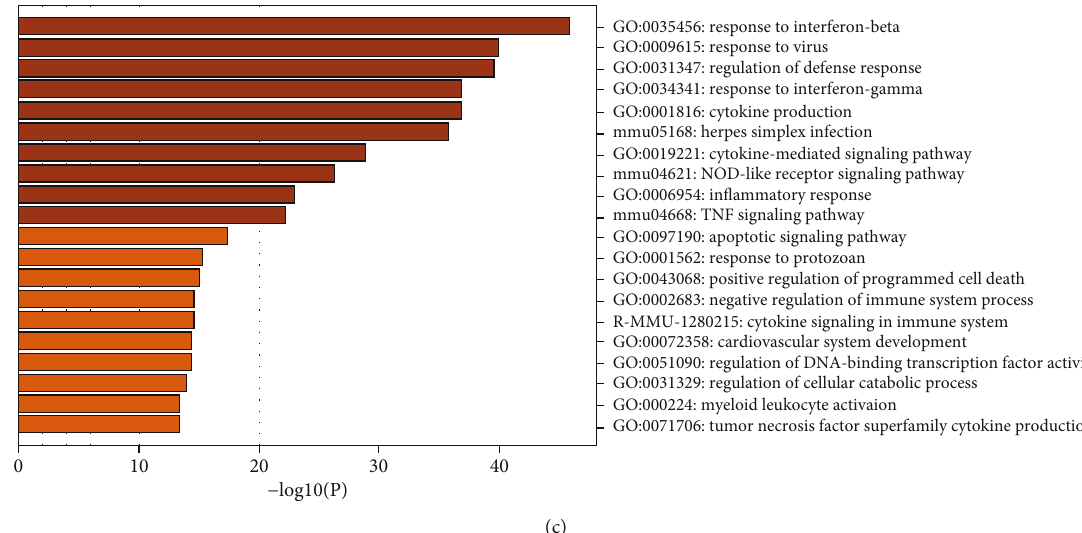
Figure 4: Microarray analysis highlighting di ff erentially expressed genes in preconditioned MSCs. (a) Heatmap representing gene expression in MSCs with and without preconditioning. (b) Top 30 of up- and downregulated genes in MSCs after preconditioning. (c) GO enrichment analysis for upregulated genes in preconditioned